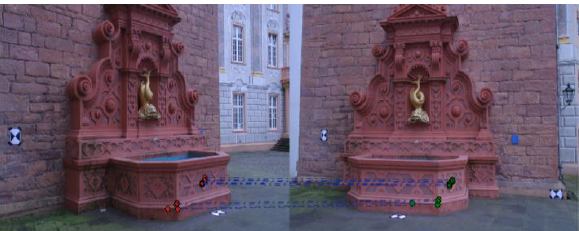
Figure 3. Mismatches outputs from GTM due to similar local neighbor structure